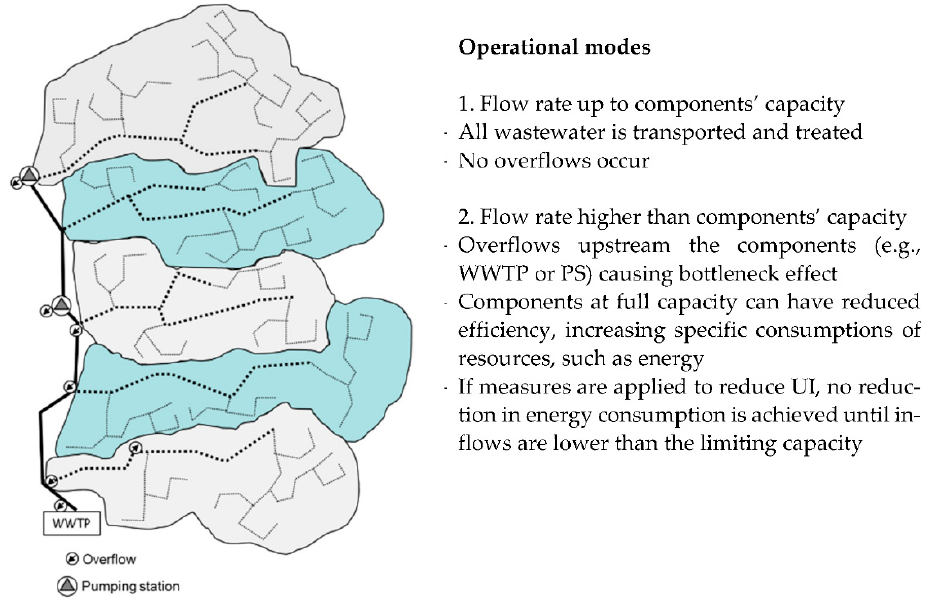
Figure 2. Integrated view of the system.